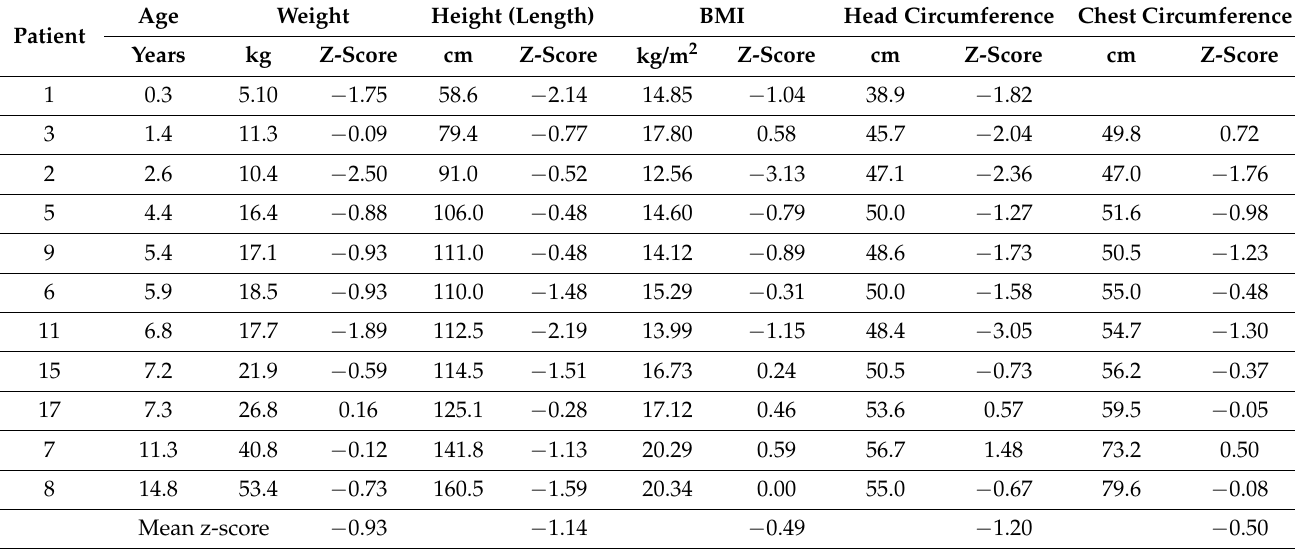
Table 2. Anthropometric characteristics of children with KBG syndrome—measurement results and normalized values.